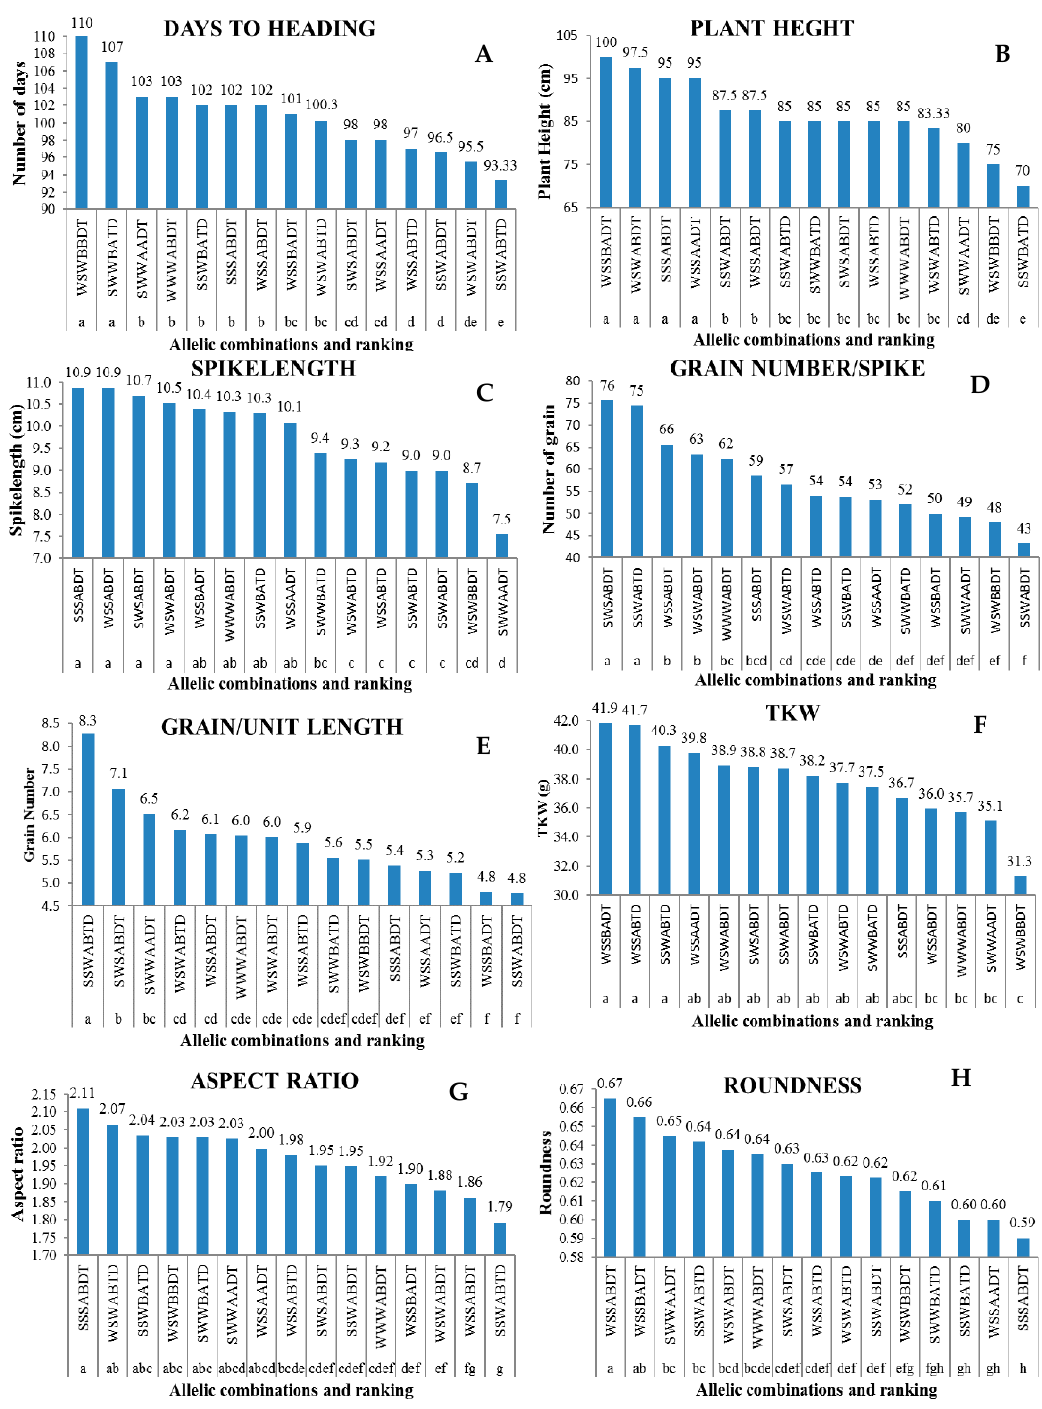
Figure 3. Comparison of the allelic combination effects on ( A ) days to heading; ( B ) plant height; ( C ) spike length; ( D ) grain number per spike; ( E ) spikelet fertility (grain per unit spike length); ( F ) thousand-kernel weight; ( G ) aspect ratio; and ( H ) roundness. Letters at the bottom of each allelic combination indicate level of significant.